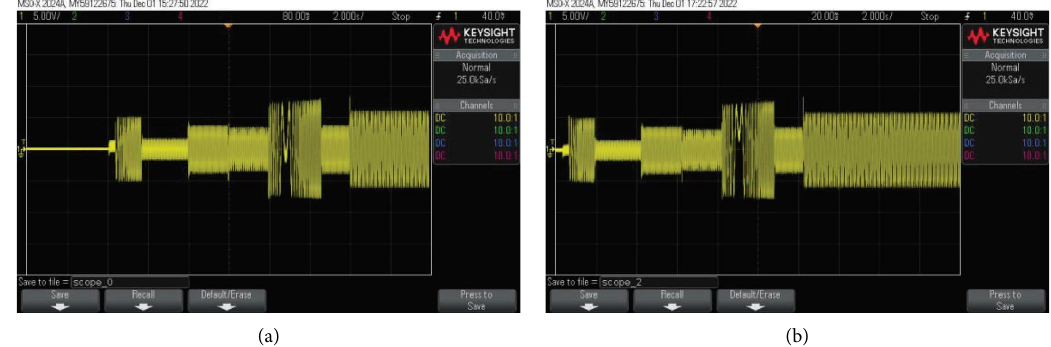
Figure 16: Experimental test results of four quadrant operation: (a) winding current of phase a ; (b) winding current of phase x .